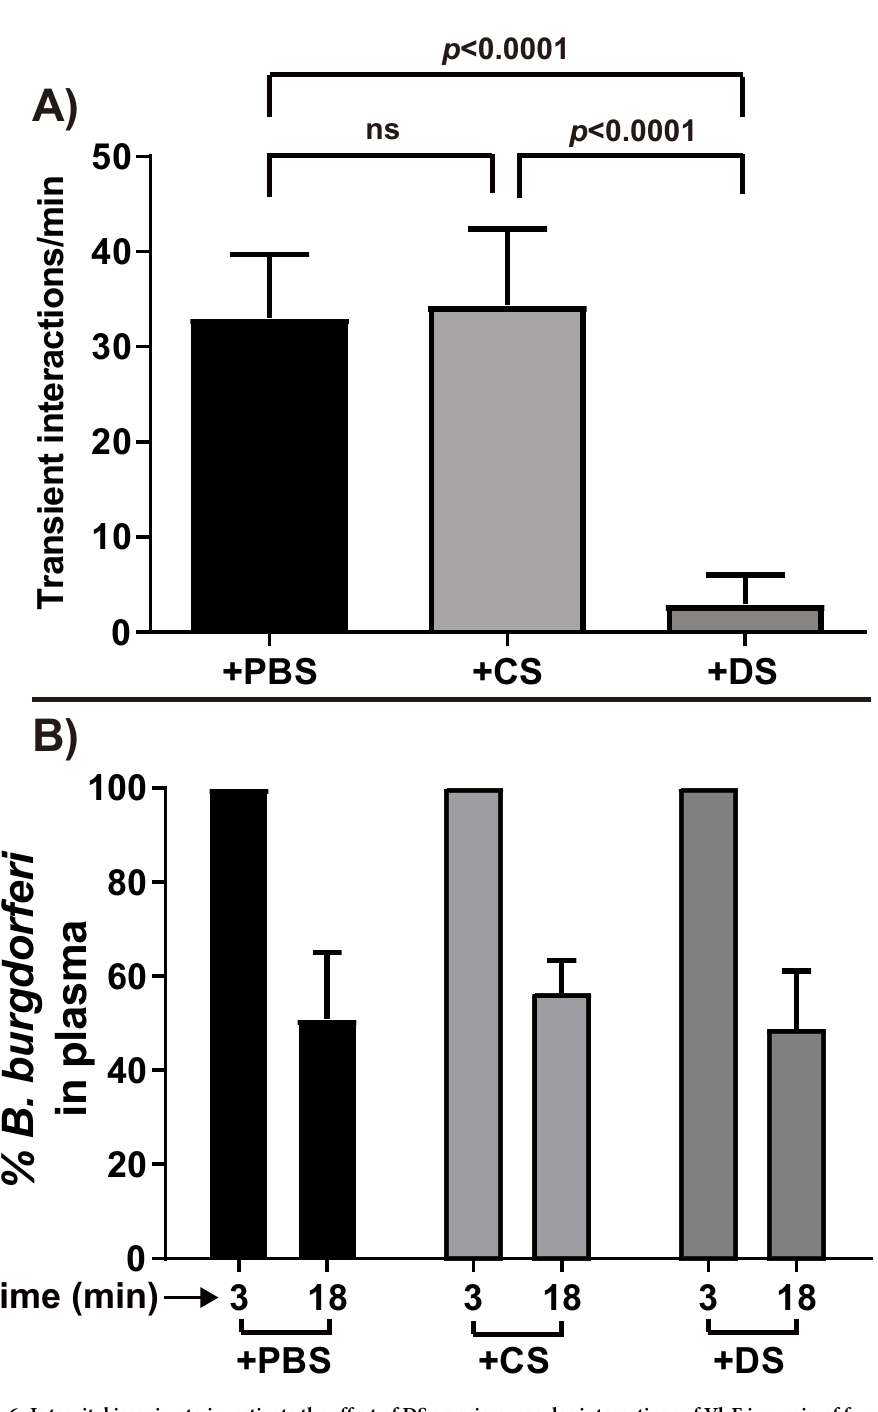
Fig 6. Intravital imaging to investigate the effect of DS on microvascular interactions of VlsE in a gain of function strain (see Table 1 for strain info). A) Mice were infected with a VlsE gain of function strain (GCB3023) and were injected either with 1.5 mg of DS or 1.5 mg chondroitin-4-sulfate (CS), or PBS into the tail vein of the Cd1d -/- at the time of infection (n = 4 mice for each group). The number of interactions per minute for transient adhesions was analyzed using intravital microscopy (see Materials and Methods). Error bars represent SD and statistical significance was analyzed using the non-parametric two-stage linear step-up procedure of Benjamini, Krieger and Yekutieli. B) Clearance of B . burgdorferi from the vasculatures in the infected mice used in panel A was monitored with the same method as in Fig